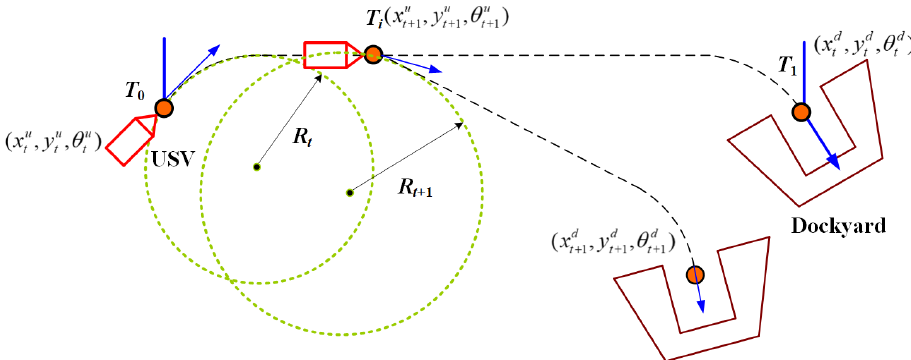
Figure 7. Varying-radius Dubins